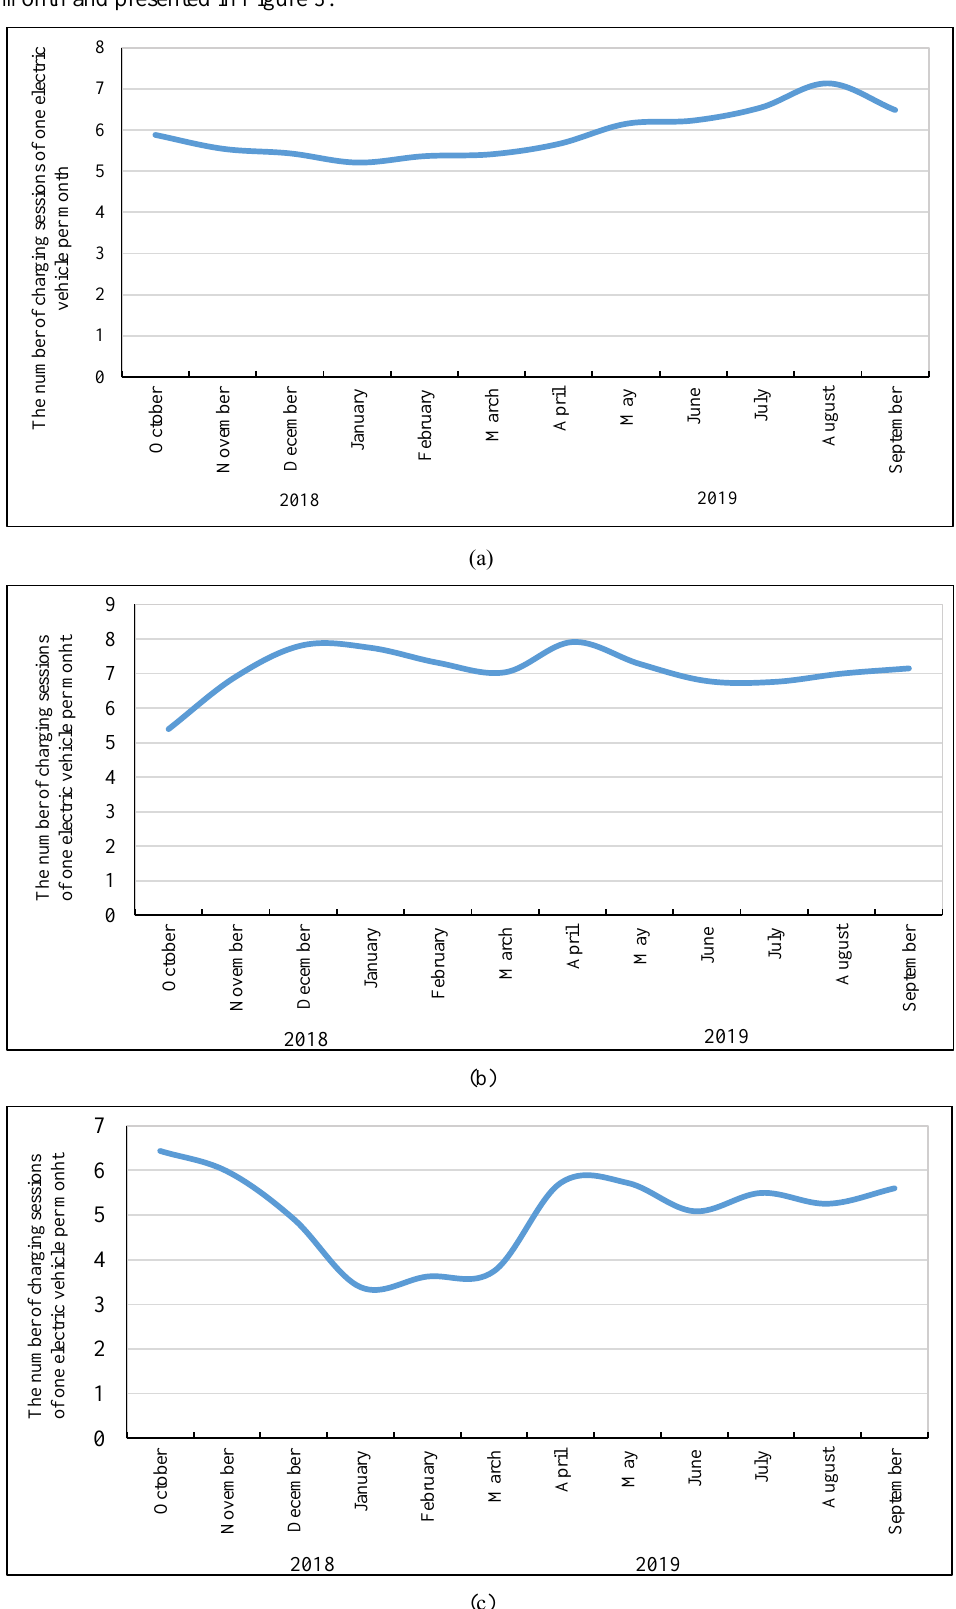
Figure 3. Curves of changes in the number of charging sessions performed by one electric vehicle, carried out by public charging infrastructure for a month in: (a) Krasnodar; (b) Yekaterinburg; (c)